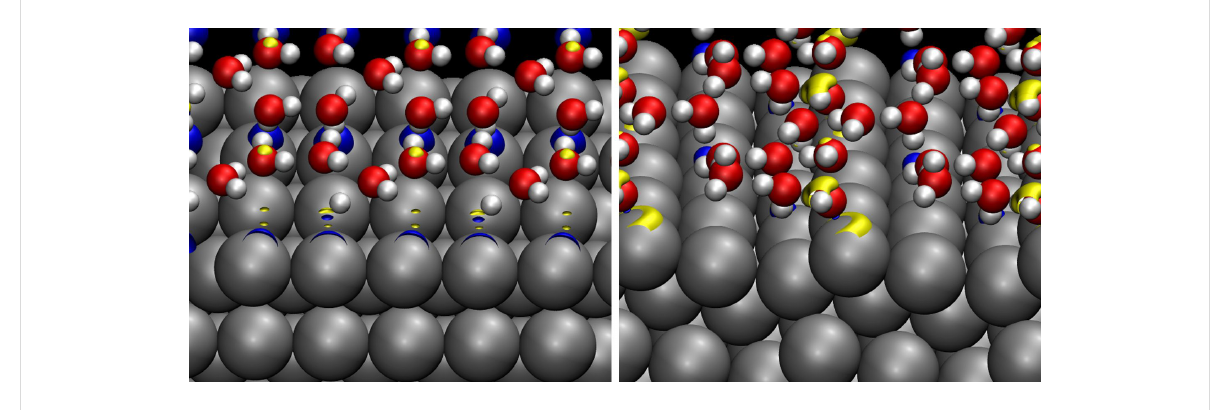
Figure 4: Isosurface plots of charge-density differences upon water adsorption on a) Pb(100) and b) Pb(511). The plotted isosurfaces correspond to charge density with an absolute value of 0.006 e /Å 2 . Charge accumulation, i.e., an increase in the electron density, is plotted in yellow, charge deple- tion in blue.